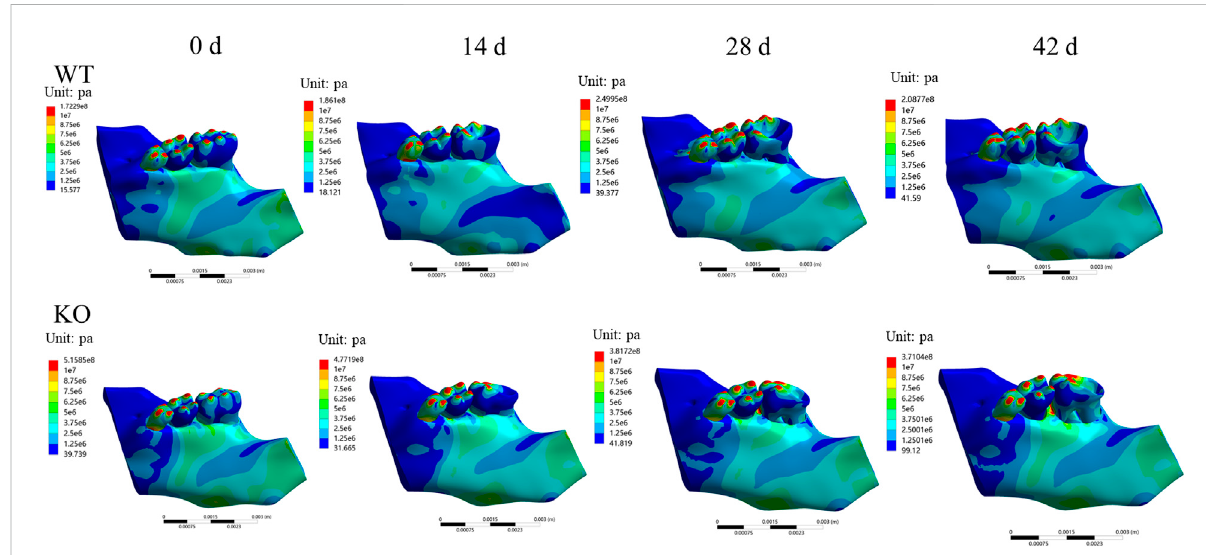
FIGURE 4 Three-dimensional reconstruction of periapical lesions in mice. Representative images of tooth in the KO group and WT group. Progressive periodontal bone loss and root exposure over